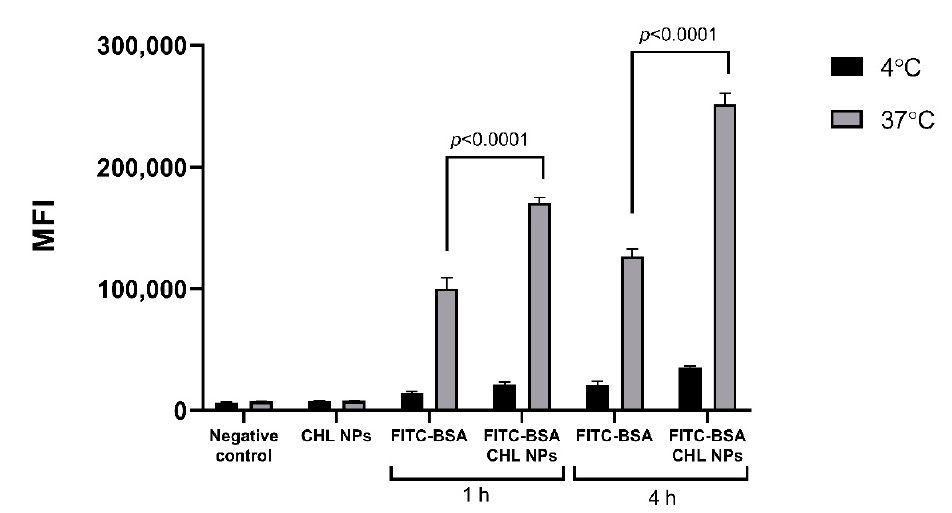
Figure 8. The association/uptake of FITC-BSA in cationic CHL NPs, by DCs. DCs were incubated with FITC-BSA incorporated CHL NPs for either 1 or 4 h, at either 4 or 37 °C ( n = 4).